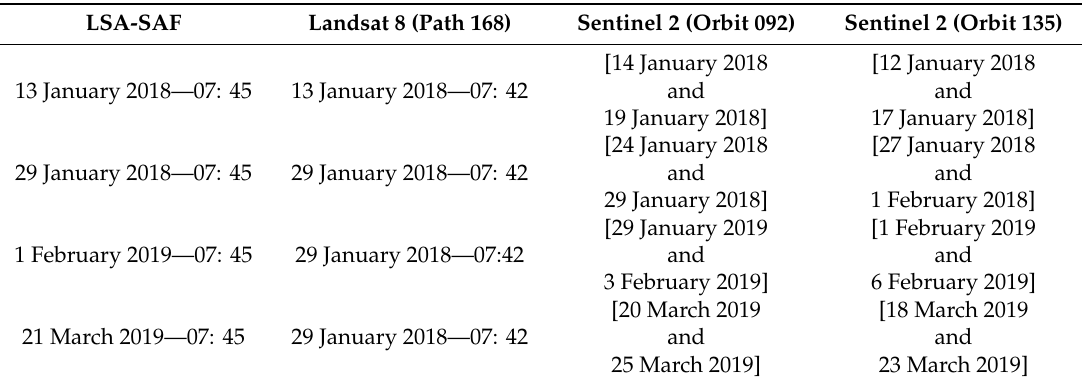
Table 2. Acquisition dates for images used in the study.